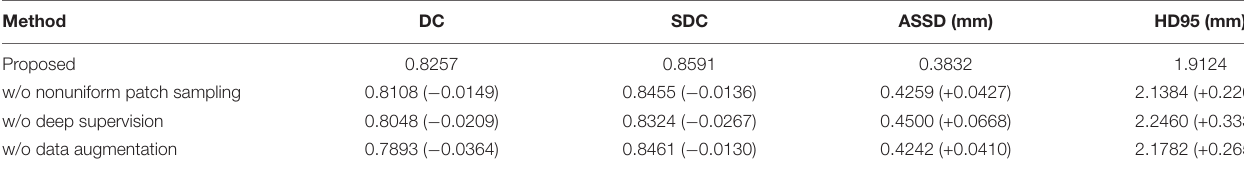
TABLE 5 | Segmentation performance on the test set under different training